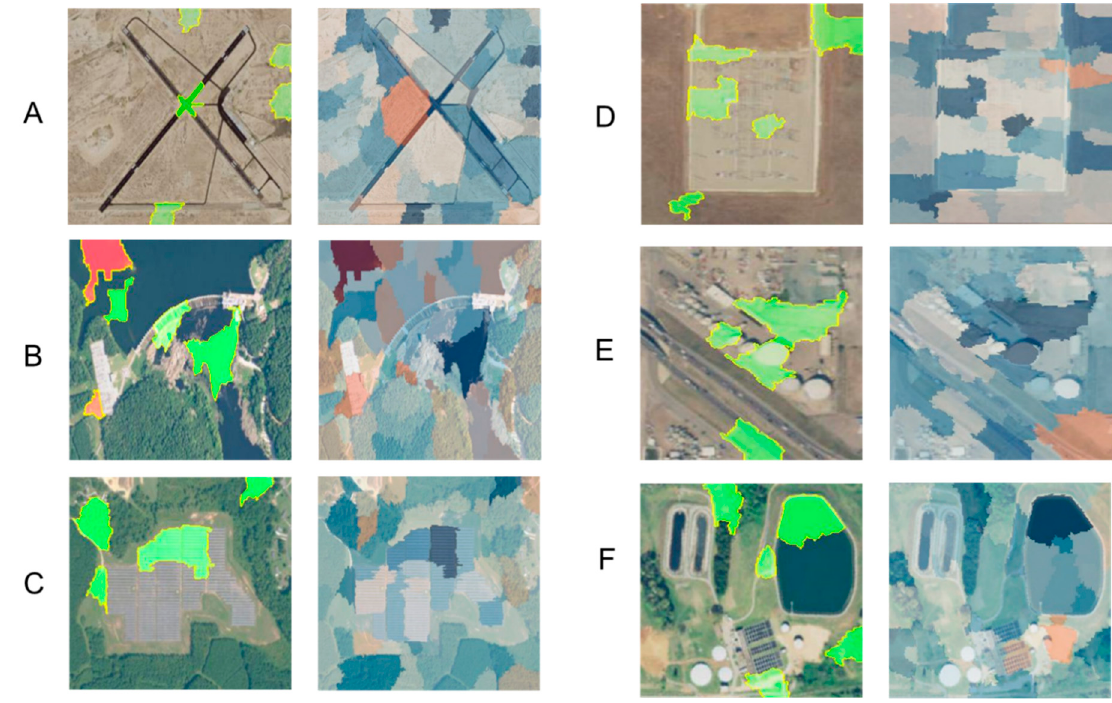
Figure 7. Sample LIME results, with red indicating areas of negative correlation and blue indicating areas of positive correlation for ( A ) airports, ( B ) hydroelectric dams, ( C ) solar panels, ( D ) substations, ( E ) petrol terminals, and ( F ) water treatment plants.